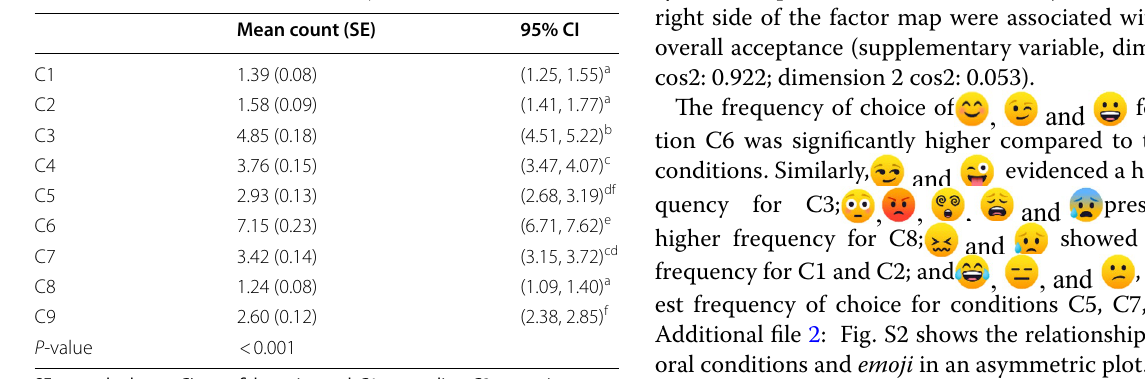
Table 1 Mean counts of overall acceptance for oral